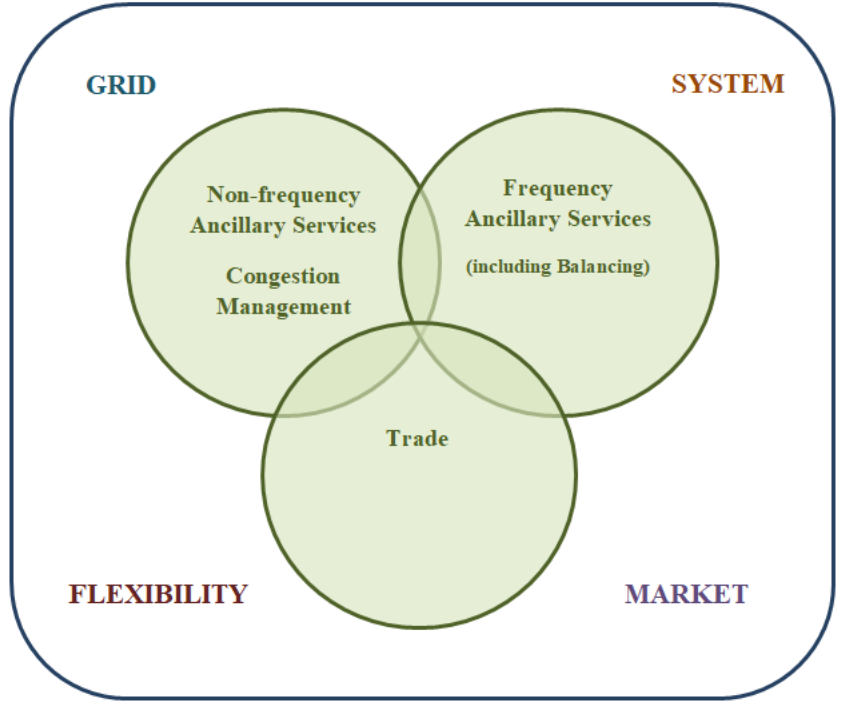
Figure 5. Flexibility services [1].